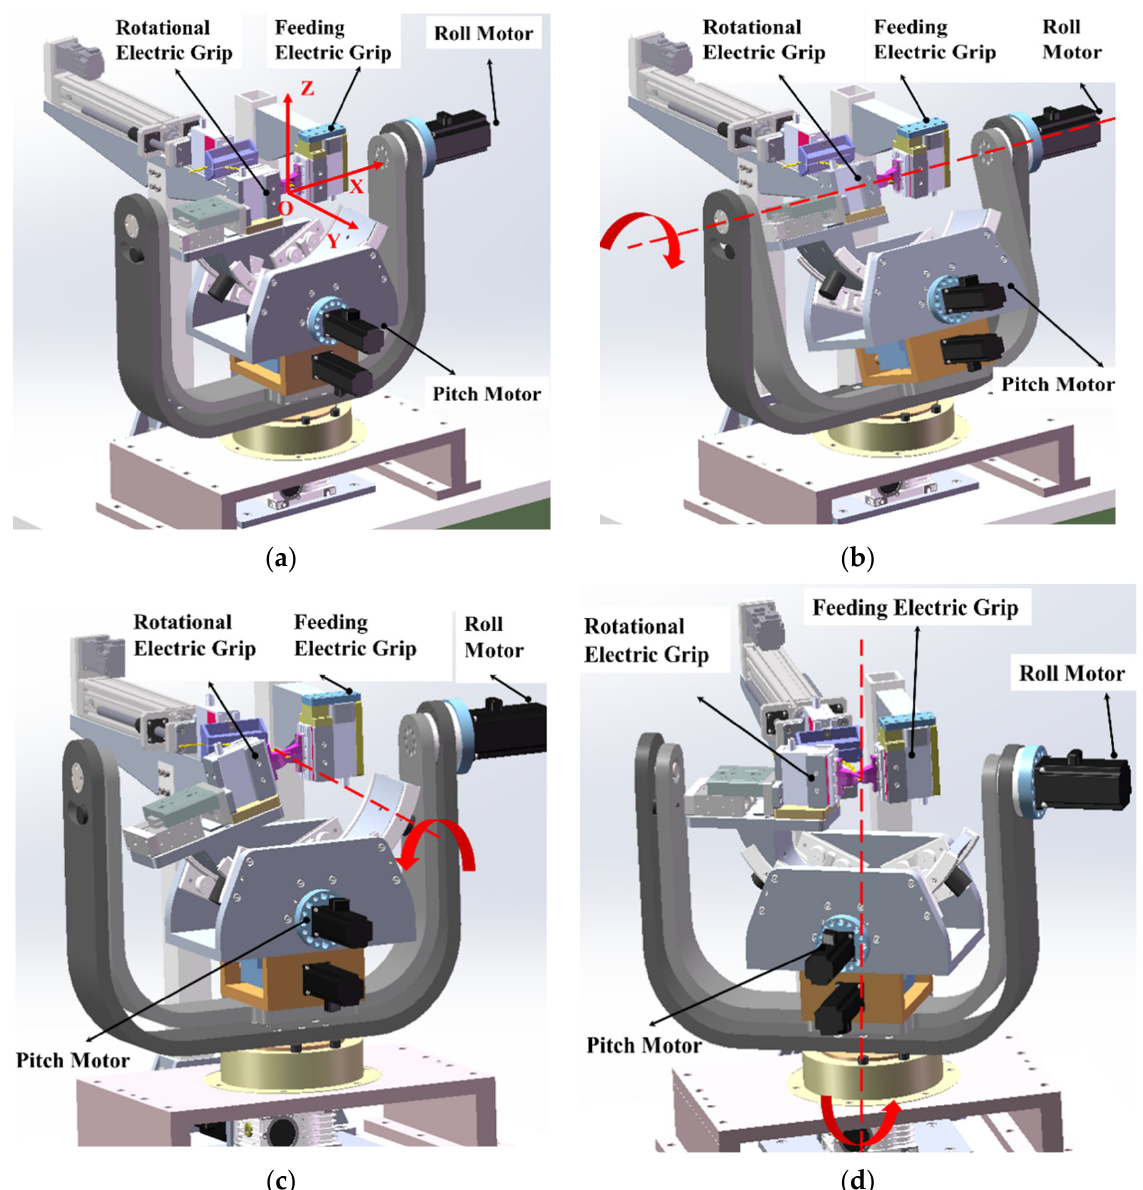
Figure 2. Robot movement along each DOF: ( a ) initial state, ( b ) movement along the roll direction, ( c ) movement along the direction, ( d ) movement along the yaw direction.